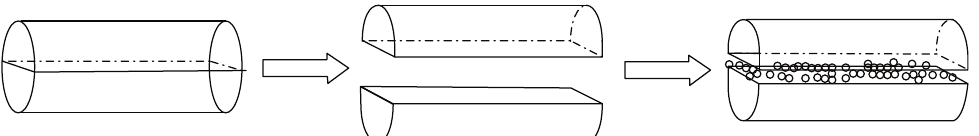
Figure 1: Physical treatment of natural cores.